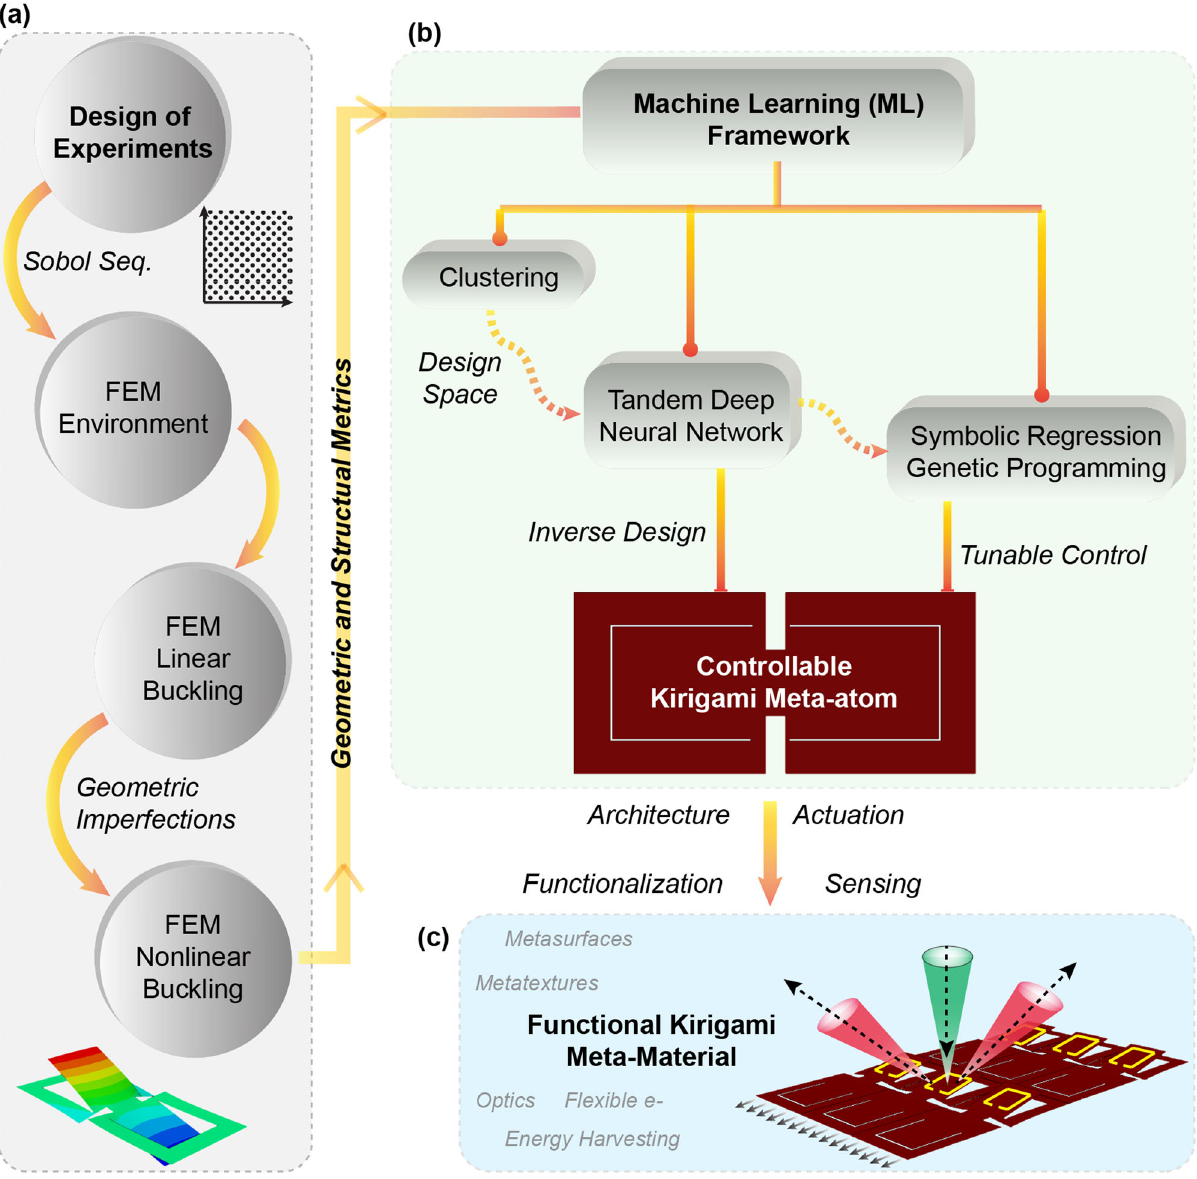
Fig. 2 General framework for the machine learning assisted design of Kirigami meta-atoms and metamaterials. a Dataset collection. b Machine learning framework. c Implementation of Kirigami machine learning